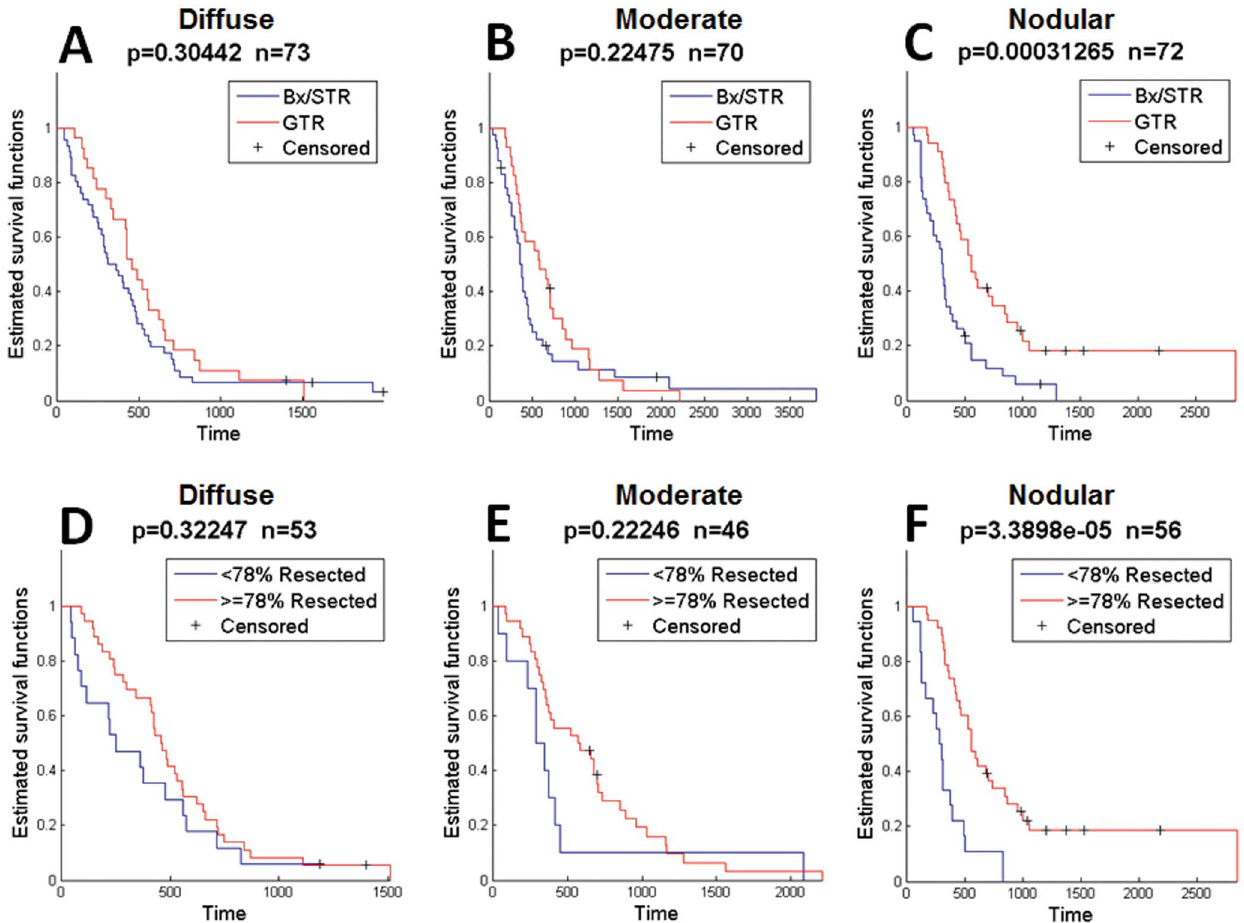
Figure 5. Survival Curves for Highly Diffuse (low r /D), Moderately Diffuse (mid r /D), and Nodular (high r /D) for 215 WHO Grade IV glioblastoma multiforme tumors (GBMs) with sufficient imaging. Comparisons were made between biopsy/subtotal resection (BX/STR) and gross total resection (GTR) in GBMs at first surgical presentation. GTR imparted no significant survival benefit in the highly diffuse (A) and moderately diffuse (B) GBMs. C) GTR imparted a significant survival benefit among patients with nodular GBMs, with a benefit of 239 days (8 months), or a 75% improvement over the Bx/STR group. When EOR was classified by percent of the T1Gd volume removed, with 76% selected as the cut off, the same selective survival benefit is observed in the nodular cohort (D–F, p=0.0000339). The limits between highly diffuse and moderately diffuse, and between moderately diffuse and nodular r /D were 0.439 mm 2 2 and 1.36 mm 2 2 , respectively.